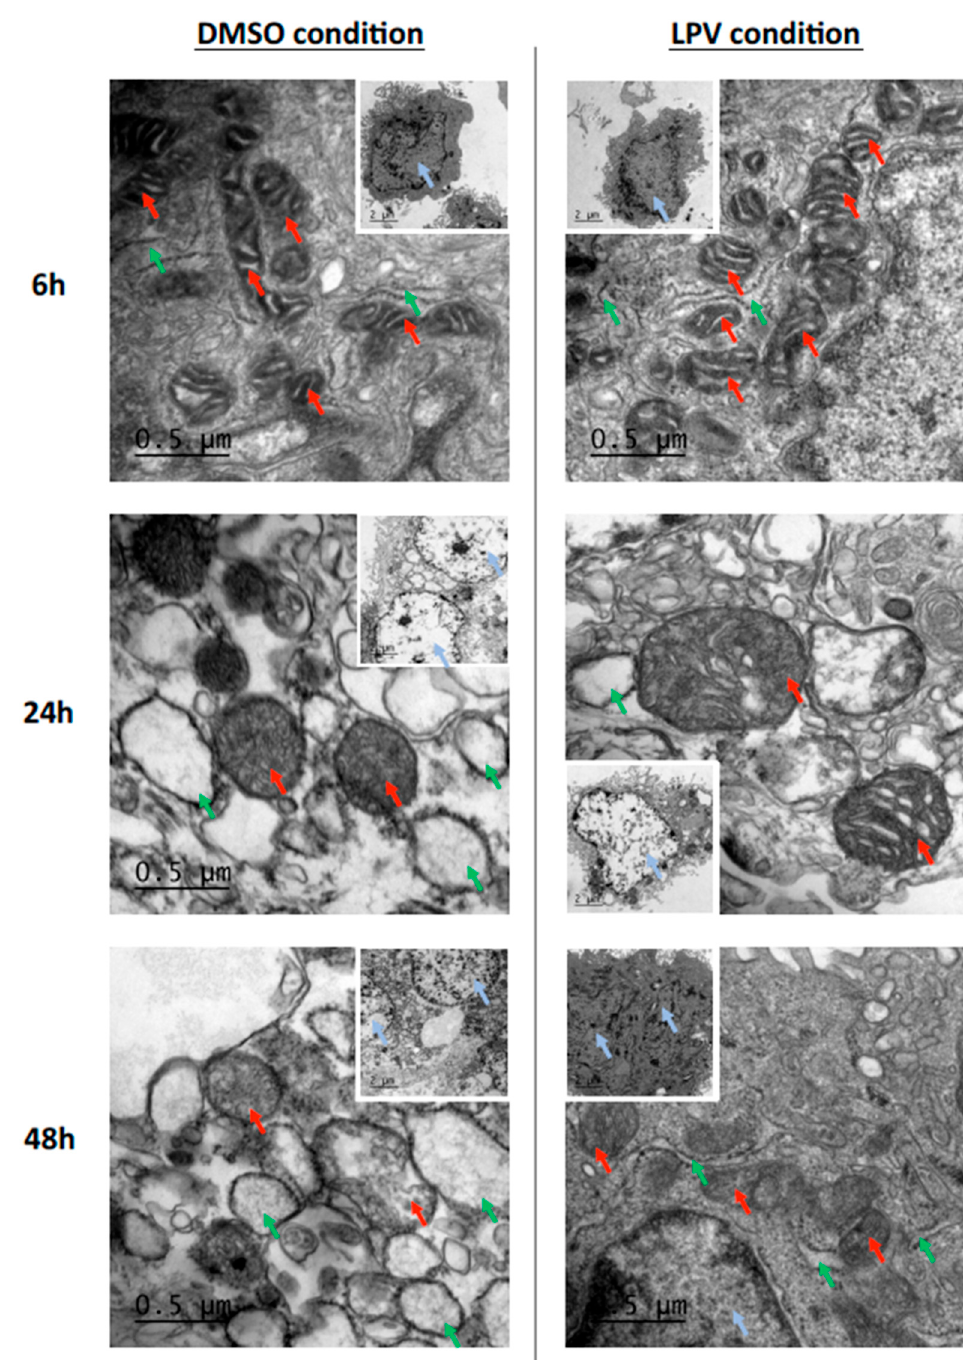
Figure 5. Lopinavir alters mitochondria and endoplasmic reticulum structure during trophoblast differentiation. Cytotrophoblasts isolated and purified from term placenta were cultured for 15 h and then incubated with LPV 10 µM or DMSO for 6 h, 24 h or 48 h. Cells have been fixed and prepared for transmission electronic microscopy. The blue, red and green arrows indicate respectively the nuclei, mitochondria and endoplasmic reticulum (ER). 1000 × magnification was used for the small pictures; scale bar: 2 µm. Zoom in 5000 × magnification was used for the principal pictures. Scale bar: 0.5 µm. These pictures are representative of 3 independent experiments.